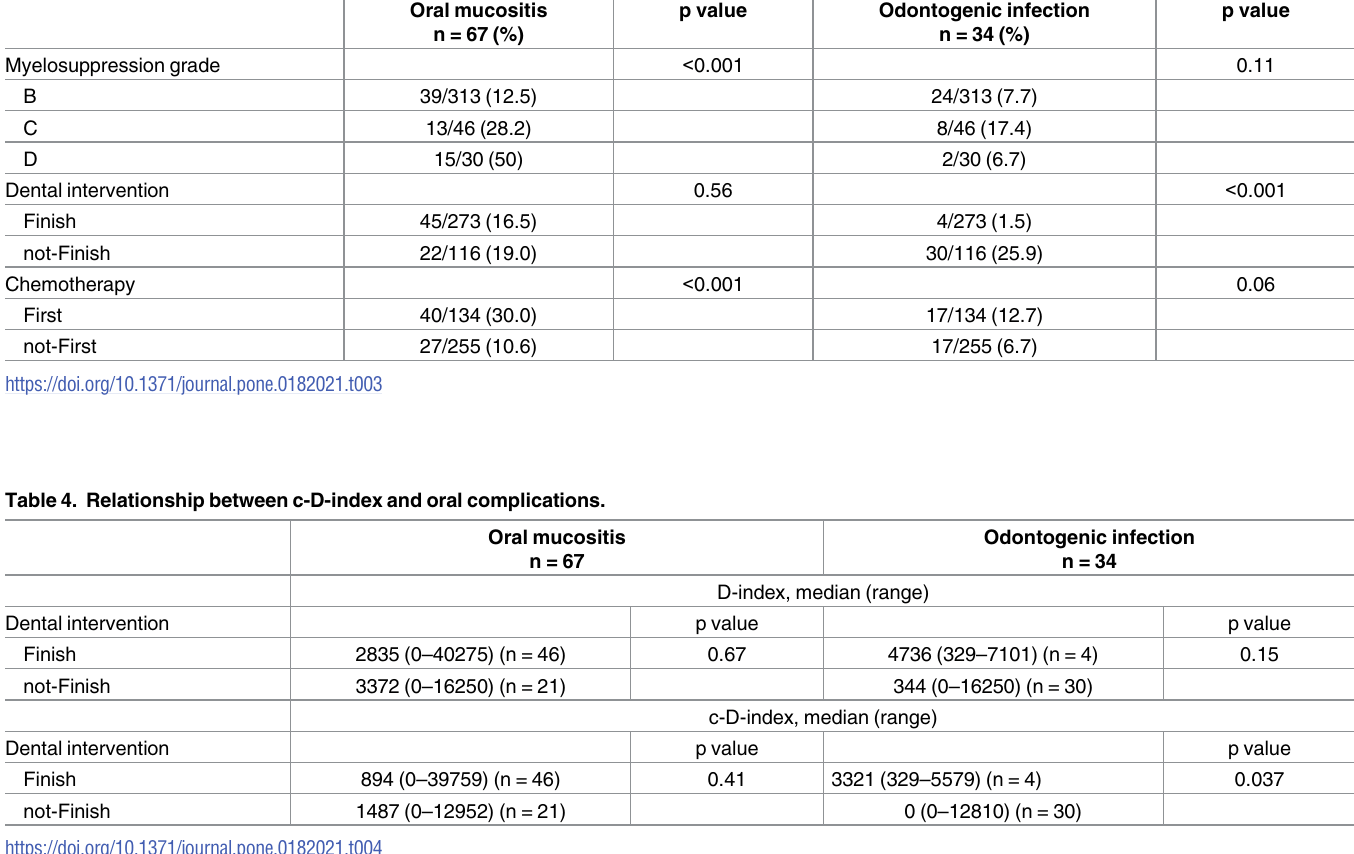
S1 Fig. Dental protocol for hematological malignancy patients, originally described by Tsuji et al [9].